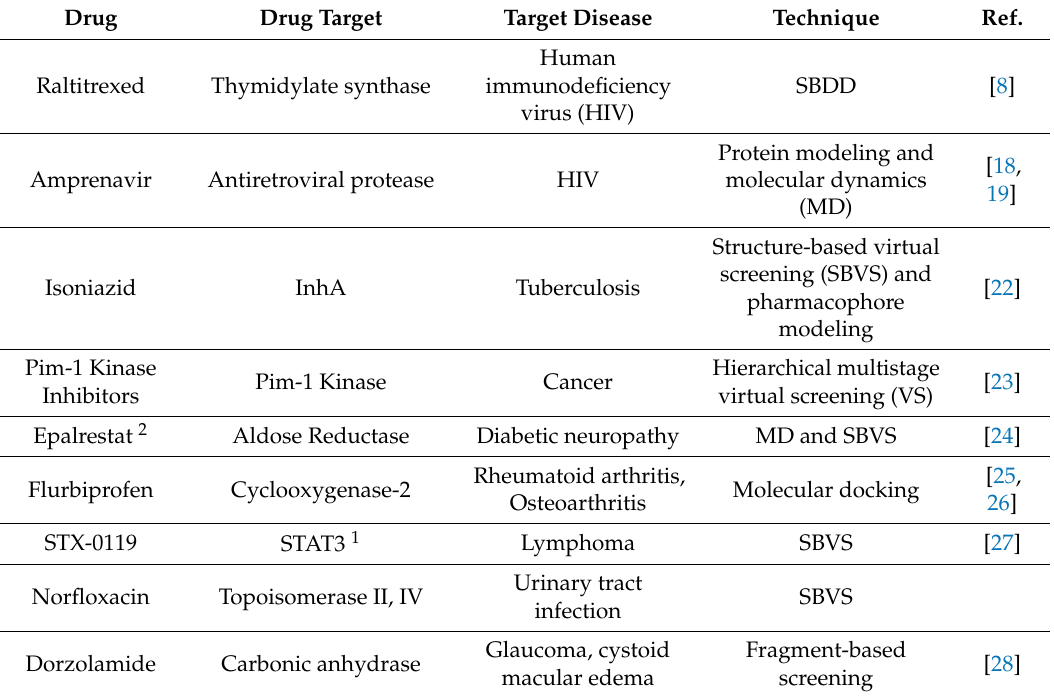
Table 1. The success cases of drug discovery by SBDD